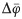
Analysis of global morphology changes in confluent cell layers.Analysis of global morphology changes in confluent cell layers by histogram-based evaluation of quantitative DHM phase contrast images at different time points (red: t1, purple: t2, blue: t3; t1 < t2 < t3). An increase of the cell layer surface roughness Δd (a) causes a shift of the histogram (b) and the average phase contrast Δφ¯ (vertical lines in (b)) towards higher phase values.